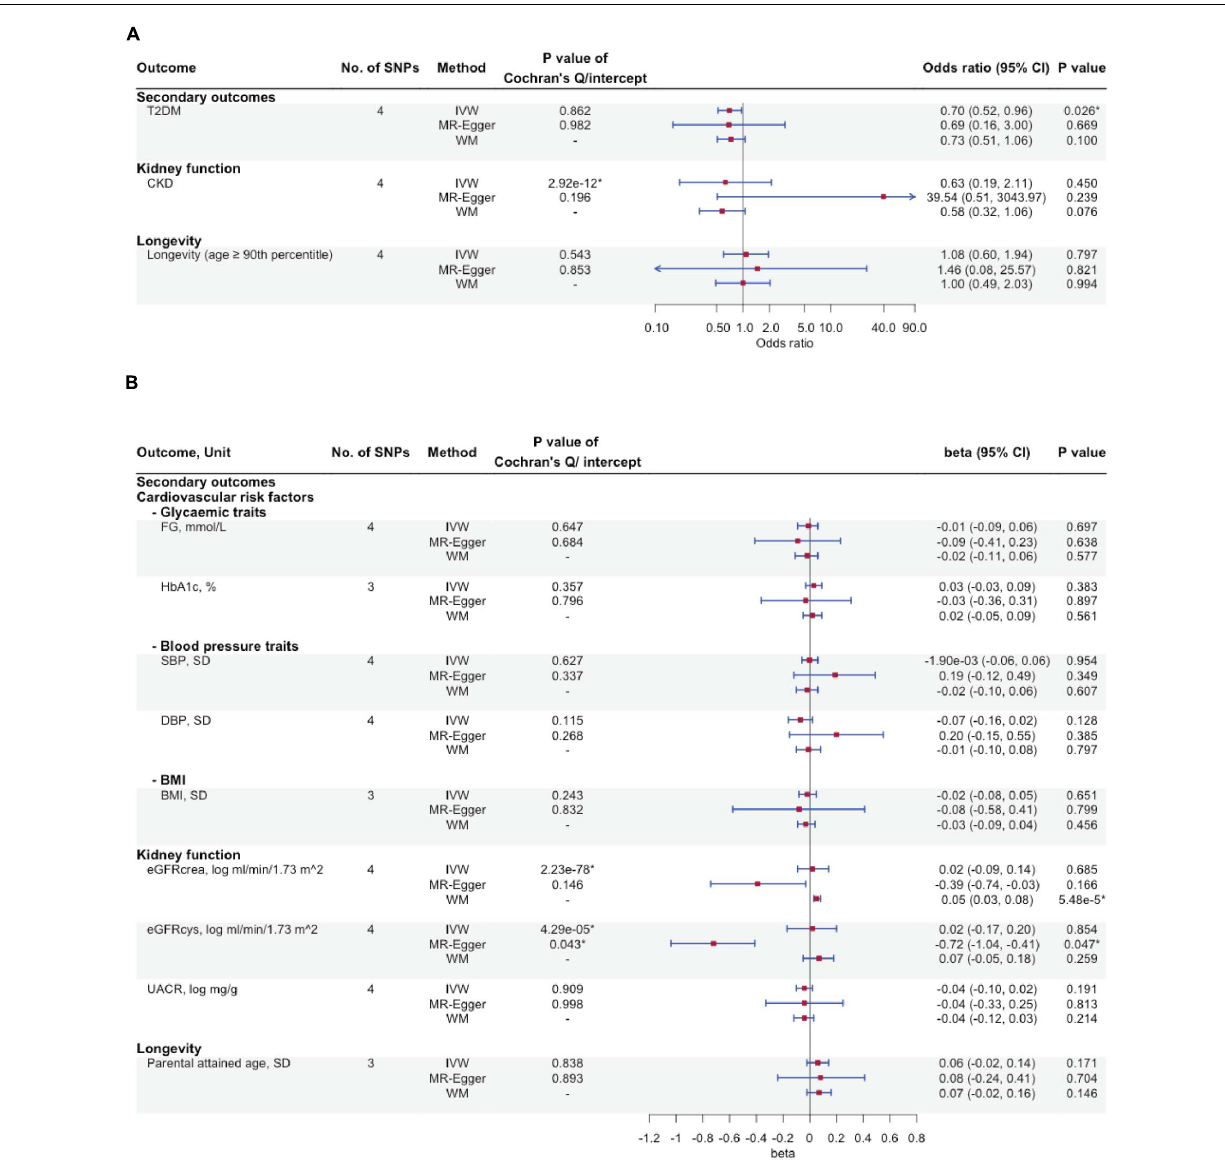
FIGURE 3 | The associations of genetically predicted FGF23 and cardiovascular risk factors, kidney function, and longevity using Mendelian randomization. (A) Type 2 diabetes mellitus, chronic kidney disease, and longevity; (B) Glycaemic traits, blood pressure traits, BMI, kidney function and longevity. No. of SNPs, number of single nucleotide polymorphisms; IVW, inverse-variance weighted; WM, weighted median; T2DM, type 2 diabetes mellitus; CKD, chronic kidney disease; FG, fasting glucose; HbA 1 c , glycated hemoglobin; SBP, systolic blood pressure; DBP, diastolic blood pressure; BMI, body mass index; eGFRcrea, estimated glomerular filtration rate from creatinine; eGFRcys, estimated glomerular filtration rate from cystatin C; UACR, urinary albumin-to-creatinine ratio. ∗ P -value <